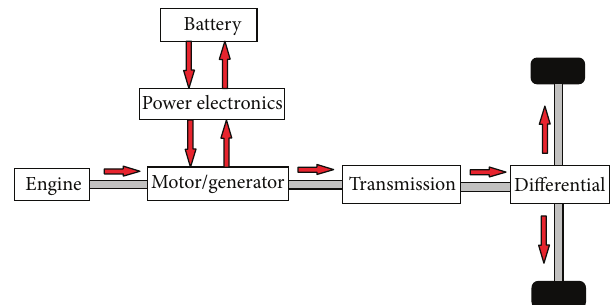
Figure 8: Electric hybrid concept (adopted from [6]).